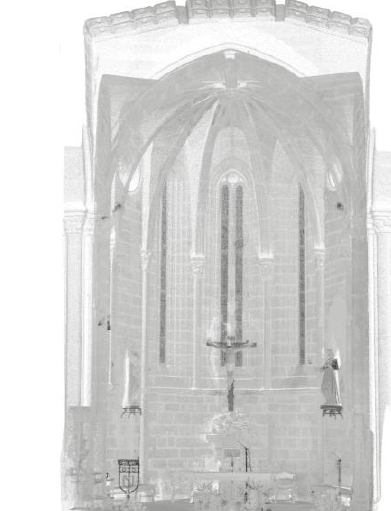
Figure 16. NCTech iSTAR point cloud. Figure 17. NCTech iSTAR textured mesh.